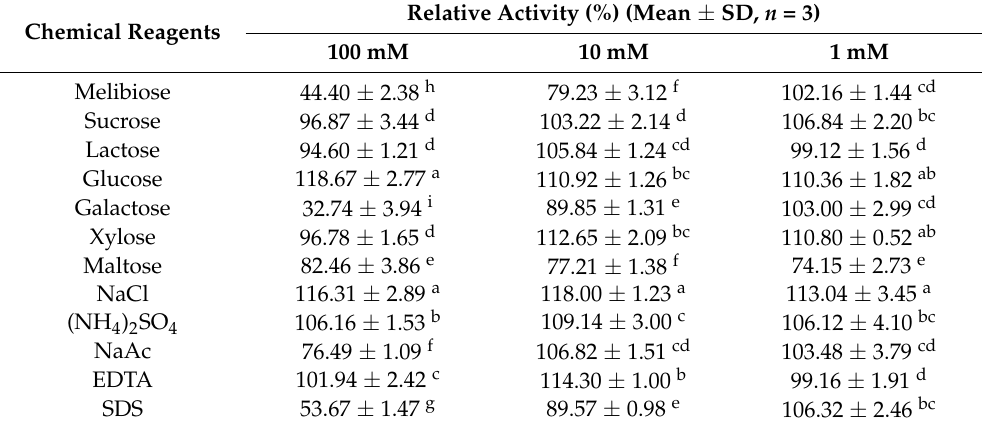
Table 4. Effects of chemical reagents on the activity of ORG.